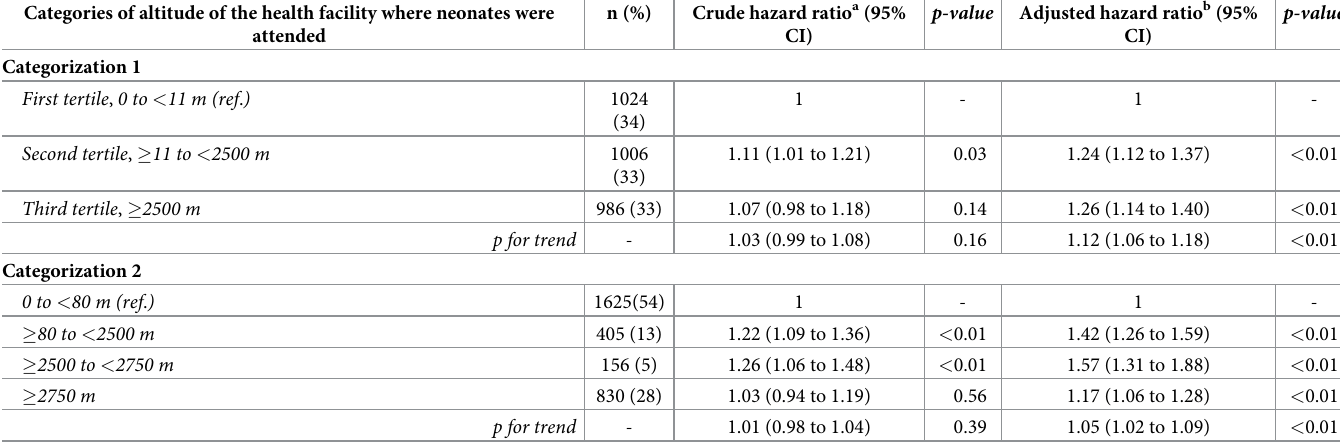
Table 2. Crude and adjusted hazard ratios of the incidence rate of death per each altitude stratum, estimated by fixed effects Cox proportional hazards models for two different types of categorization of altitude of the health care facility where neonates were attended. Categories of altitude of the health facility where neonates were attended